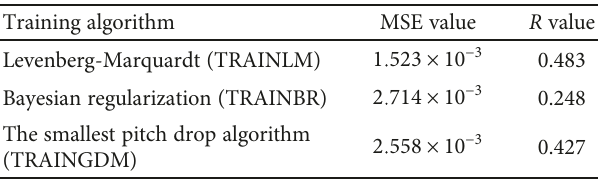
Table 3: Values of MSE and R depending on the training algorithms (for one neuron in the hidden layer) in model ANN 1.